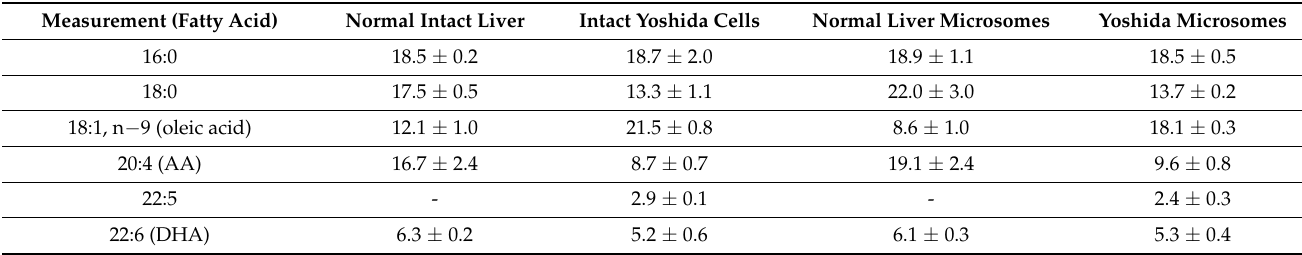
Table 4. Content of fatty acids in normal liver, hepatoma cells, and in microsomal suspensions from normal liver and Yoshida hepatoma cells. All values of mean ± S. E.